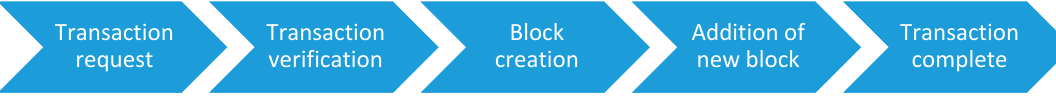
Transaction request Figure 2. Blockchain technology: process. Source: Lakshmi and Sricharan, 2019, p. 1784 [29]. So far, both scientists and practitioners have emphasized above all that with regards to financial institutions, blockchain technology provides better data infrastructures, and a better quality of delivered services that can be delivered more comprehensively and at